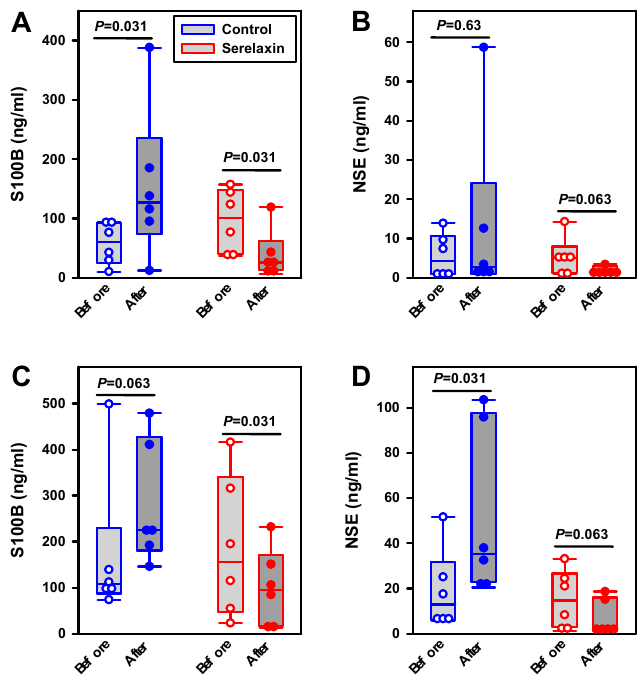
Figure 7. Effects of serelaxin on neuroprotein release into cerebrospinal fluid. Concentrations of neuroproteins S100B and neuron-specific enolase (NSE) were measured before and after experimental interventions. ( A ) S100B during hypoxia, ( B ) NSE during hypoxia, ( C ) S100B during hypovolemia, and ( D ) NSE during hypovolemia. Results are presented as box-plots (boxes represent 25th–75th percentile, with medians and individual values as circles). Comparisons of protein levels before and after interventions were made with Wilcoxon’s signed rank test; p -values are indicated in the figure. There were six animals per